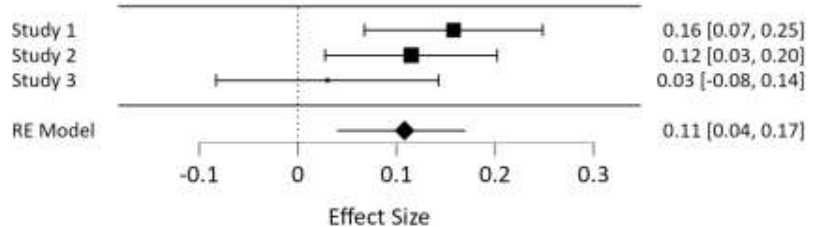
Figure 14. Forest plot of meta-analysis of Motivation for achievement and Extraversion